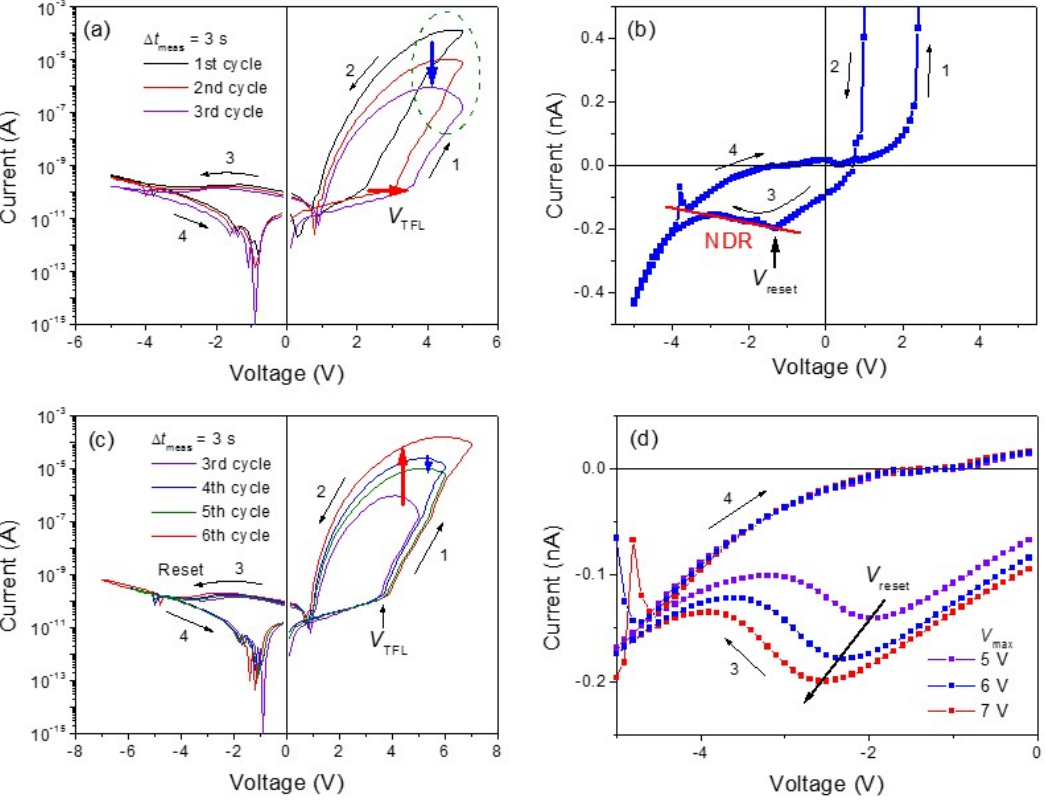
Figure 7. ( a ) Relaxation behavior of the BRS characteristics of the g -Al:MgZnO / ZnO heterostructure device just after 500 cycles of bipolar voltage pulse training. ( b ) A linear scale plot of the I-V curve for the 1st cycle of the I-V measurements showing an NDR above the reset voltage, V reset . ( c ) V max dependence of I-V characteristics of the film after the relaxation. ∆ t meas is the time interval between the measurements. ( d ) Shift of V reset to larger negative voltages for higher V max .